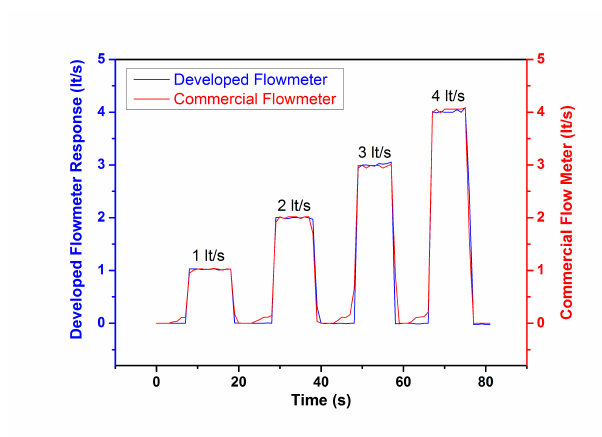
Fig. 8. The comparison of the response of developed TFMS with varying widths of the target plate against the response of the commercial